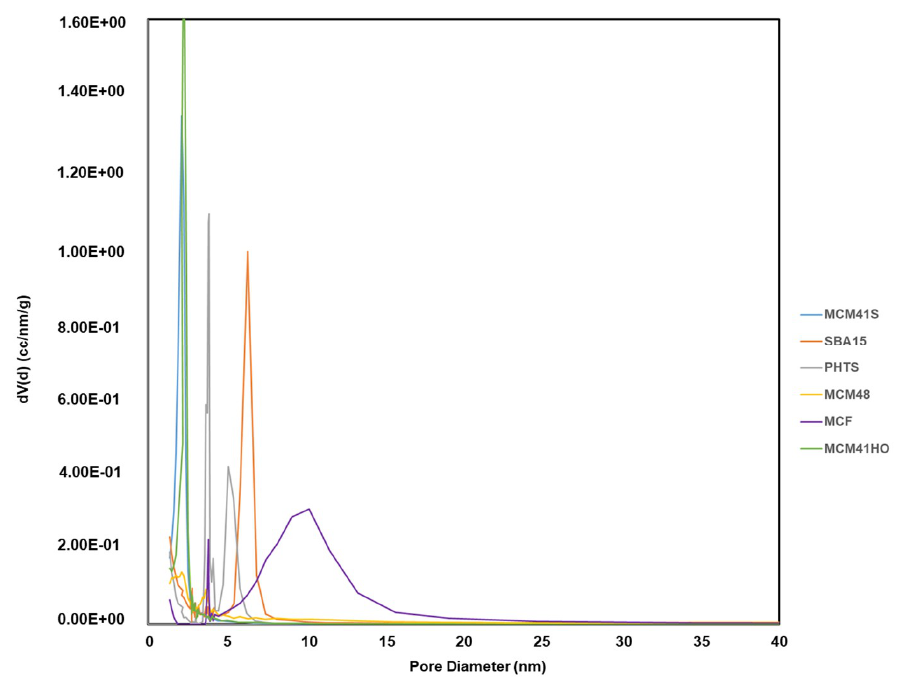
Figure 5. Pore size distribution of the prepared nanoparticles.